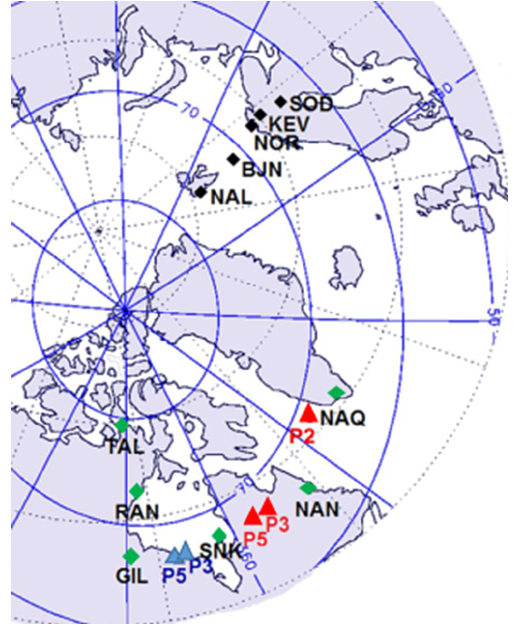
Figure 1. Instrumentation used to study the substorm events on 18 January and 19 February 2008. The magnetic conjugacy points of THEMIS probes P5 and P3 are shown with blue and red triangles (triangles in red correspond to conjugacy points of the 18 January event). During both events the locations of THEMIS instrumenta- tion (TAL, RAN, GIL, P3, P5) were at 21:00–23:00MLT and that of the Fennoscandian instrumentation (NAL, BJN, NOR, KEV, SOD) was 05:00–07:00MLT (adapted from Kauristie et al., 2013).